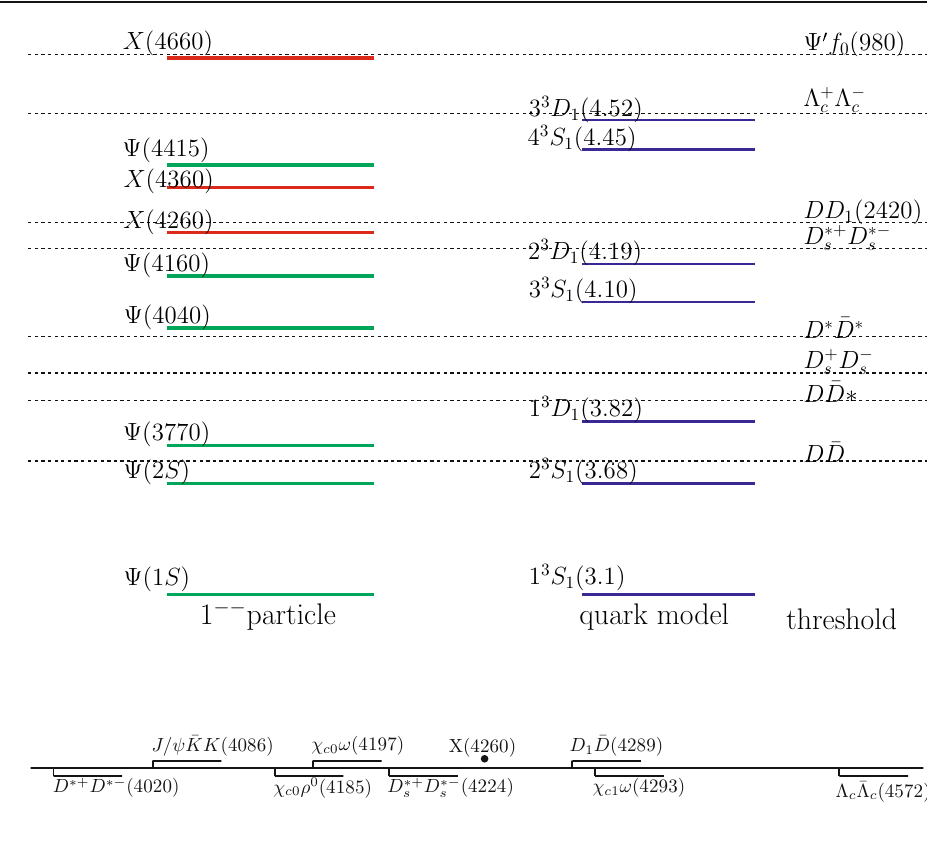
Fig. 2 Location of X ( 4260 ) and nearby